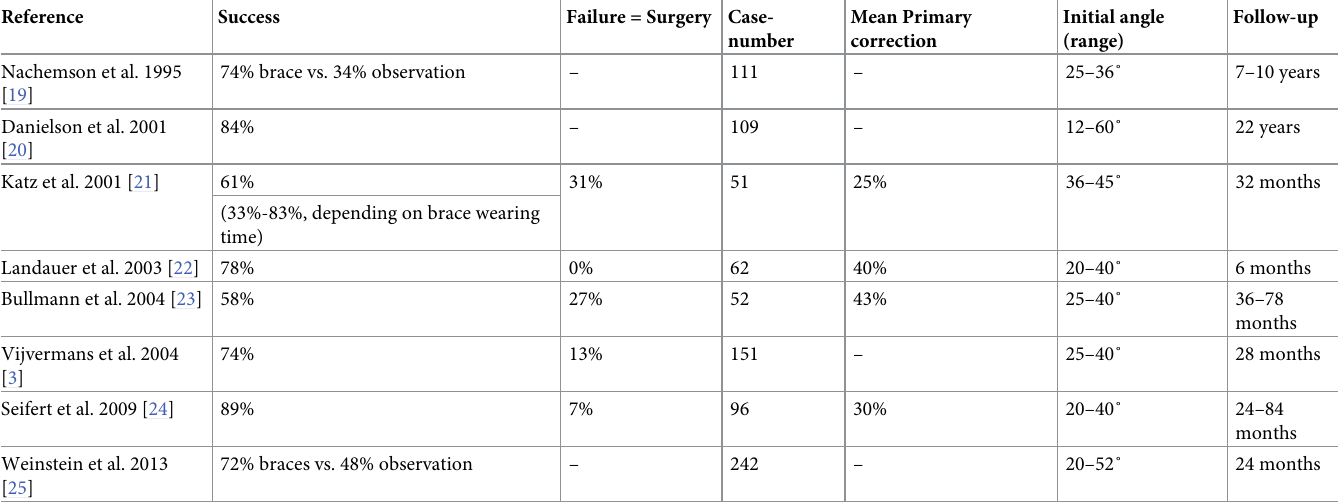
Table 3. Comparison of success rate, case number, initial angle and follow-up period according to selected literature review (— = not reported).